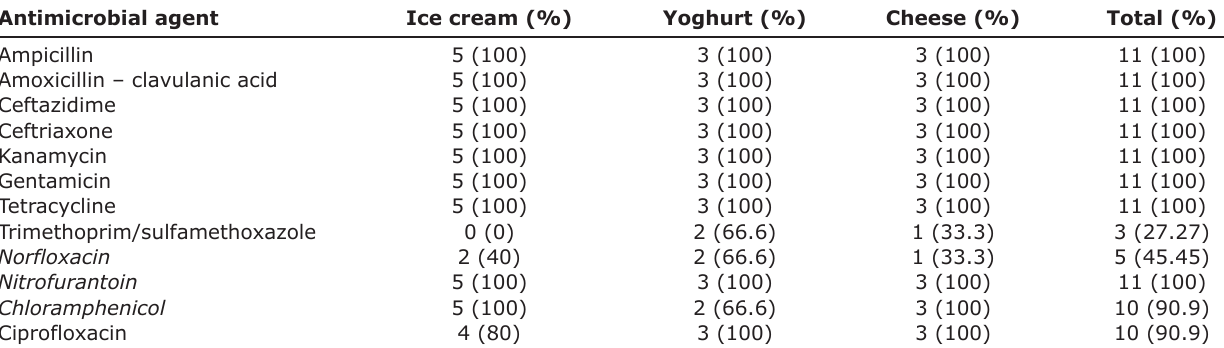
Table-3: Frequency of resistance to antimicrobial agents among E. coli isolates harboring stx1 and stx2 from traditional dairy product samples (n=116). Antimicrobial agent